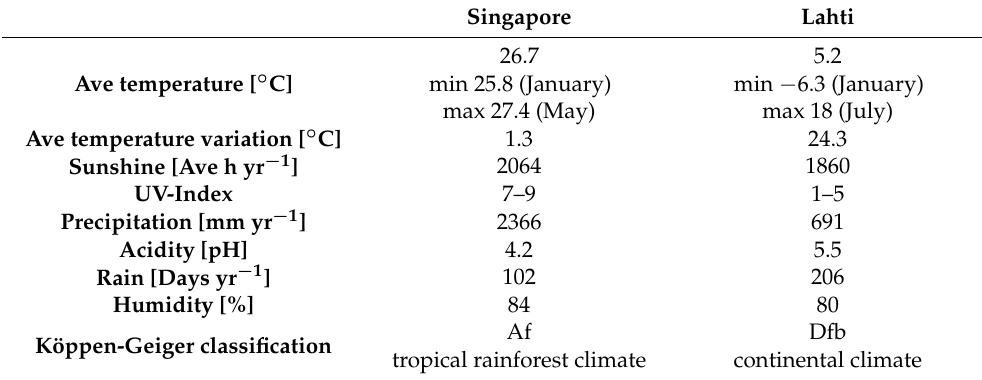
Table 1. Comparison of climate data from Singapore and Lahti